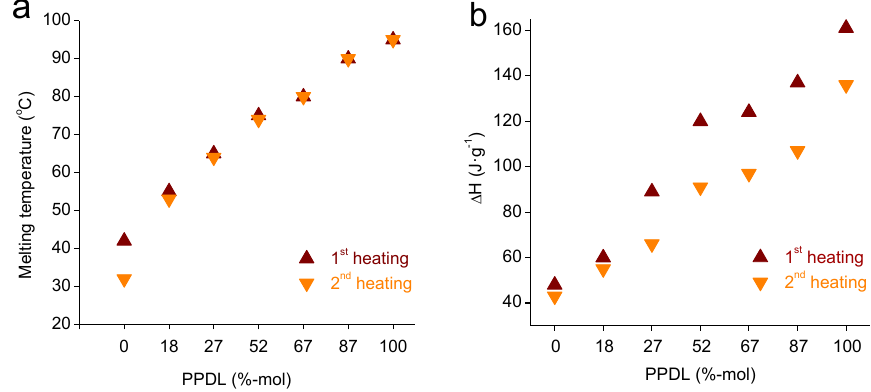
Figure 2. Melting temperatures ( a ) and enthalpies ( b ) of P(Gl x - r -PDL y ) copolyesters as a function of their monomeric composition.